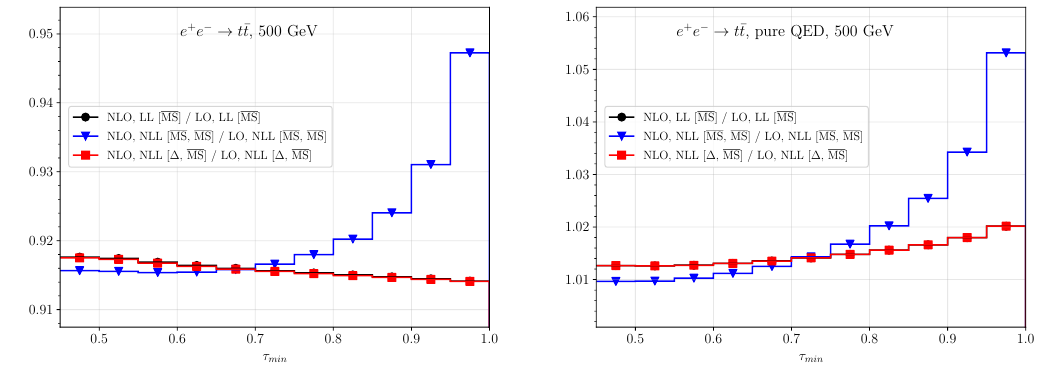
Figure 15 . As in figure 14, for t ¯ t production in the full SM (left panel) and in QED (right